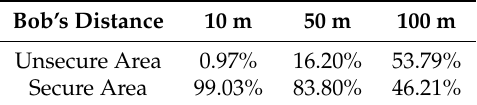
Table 1. Secrecy capacity values when Bob’s distance from Alice is equal to { 10,50,100 } m and P = 20 W. The total area covered by the BS is 9336 m 2